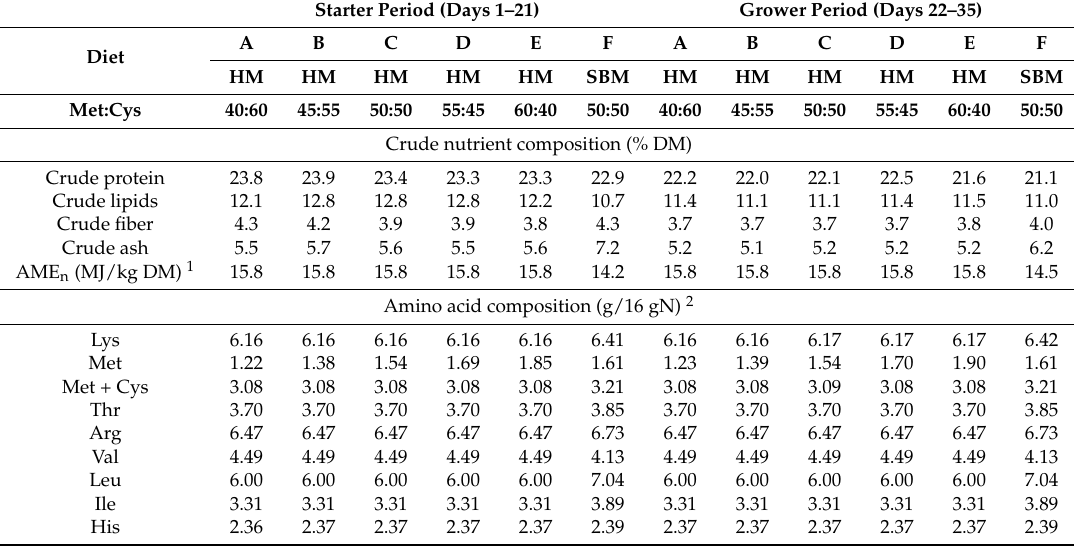
Table 3. Analyzed nutrient content of the experimental